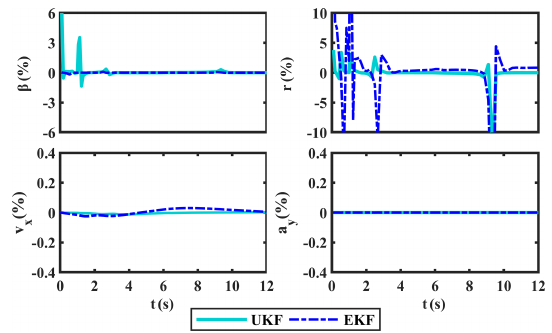
Figure 16. The relative error curve of β , r , v x , and a y under fish- hook manoeuver test II.